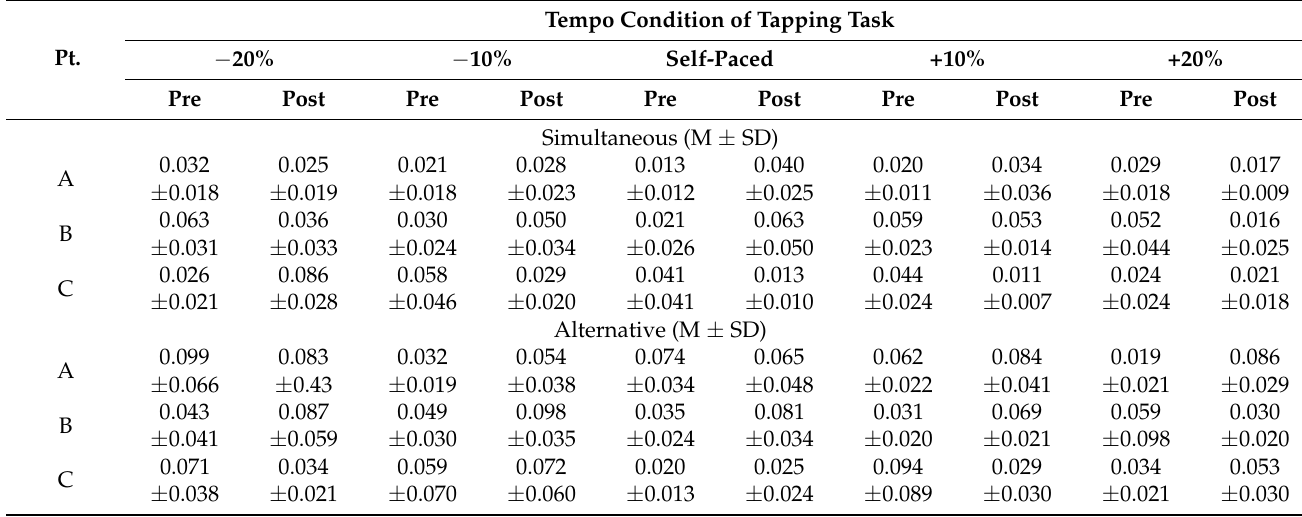
Table 4. Mean synchronization errors for each tempo condition of the drum tapping task.